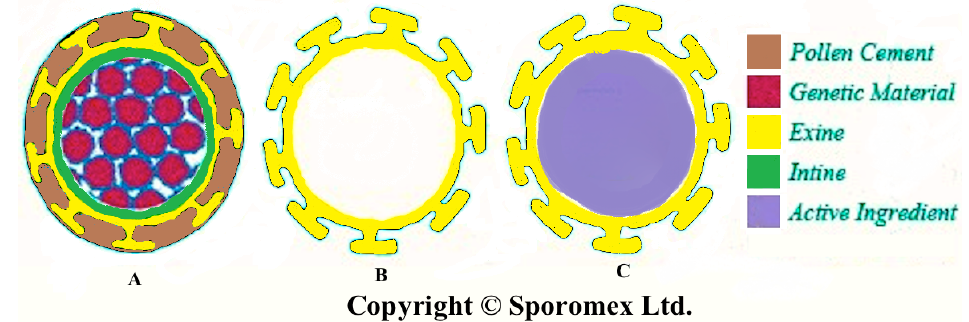
Figure 2. Schematic diagram illustrating Sporomex technology. ( A ) original spore; ( B ) empty shell; and ( C ) refilled